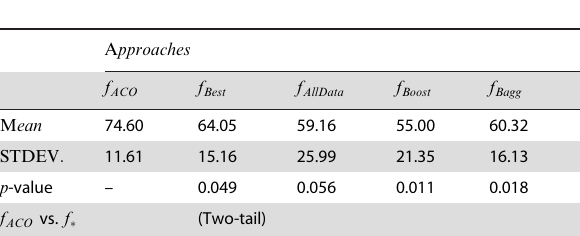
Table 10. Experimental results for CTG prediction problem.